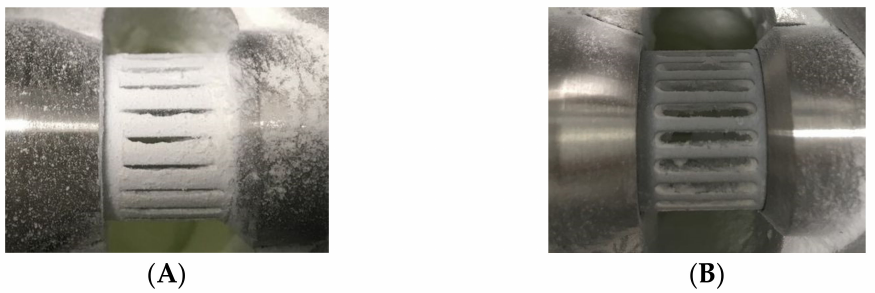
Figure 3. Product particle adhesion of theophylline at the classifier wheel after micronization: